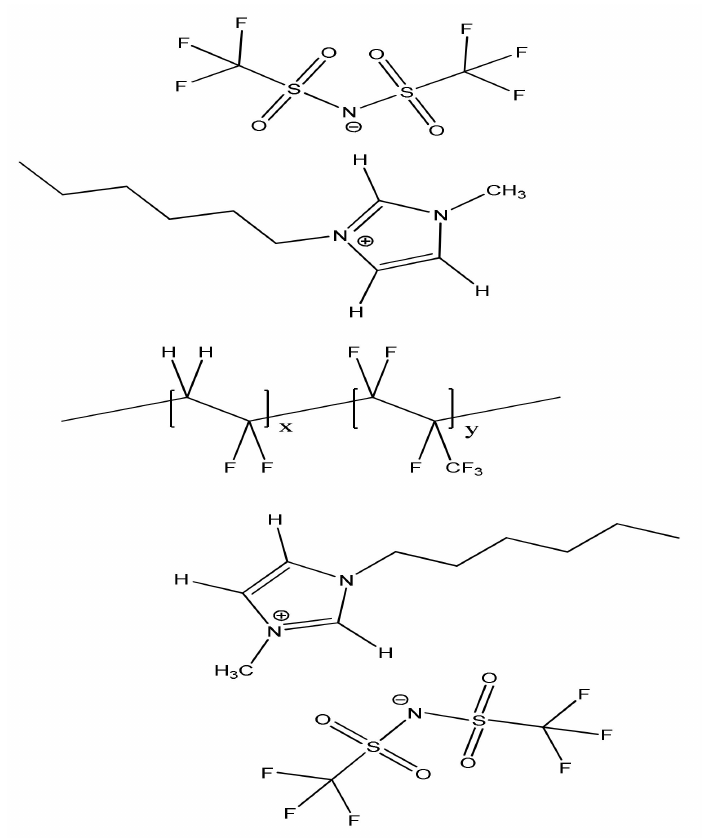
Figure 10. Illustration of the possible [HMIM][NTf 2 ]-PVdF-co-HFP structures in the